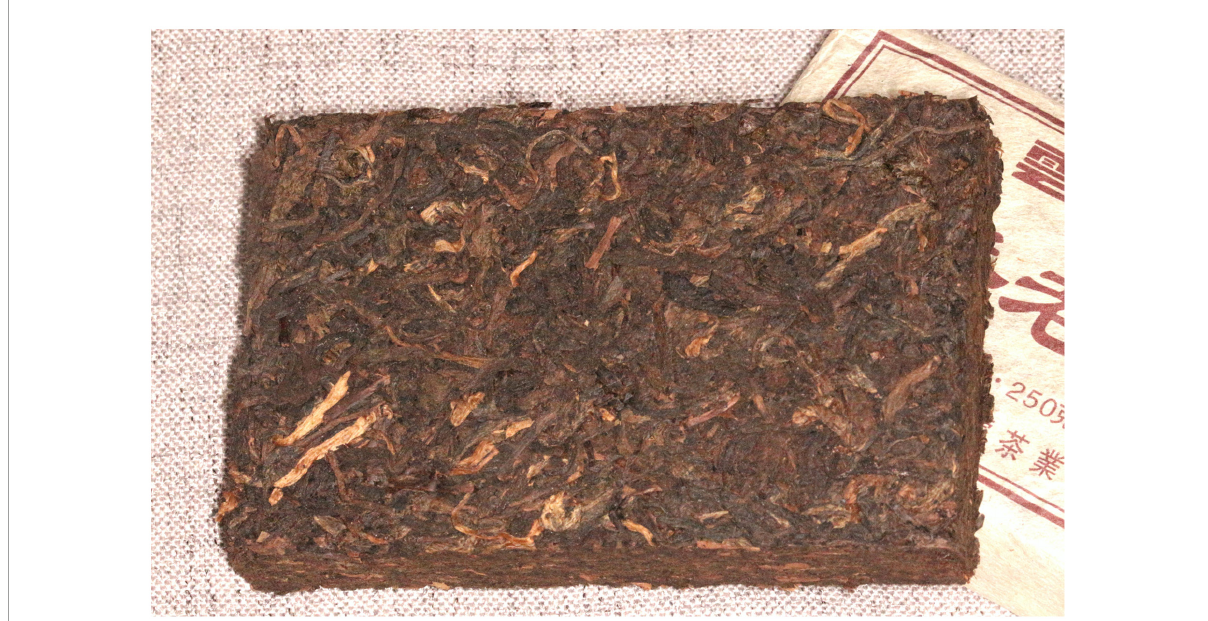
FIGURE1 A piece of brick tea produced in Yunnan province. Brick tea looks like a brick, and is a representative type of pressed tea, which is made of tea leaves, tea stems, and sometimes tea